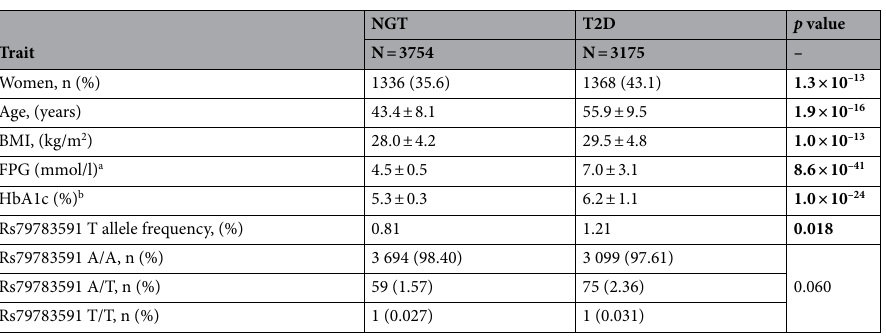
Table 1. General characteristics of Mexican adults with NGT and T2D. Data are expressed as mean ± standard deviation and N (%). NGT, normal glucose tolerance; T2D, type 2 diabetes; BMI, body mass index; FPG, fasting plasma glucose; HbA1c, hemoglobin A1c. The difference in sex ratios was analyzed using the X 2 test. Differences in means were analyzed using Student’s t-tests. Significant p values ( p < 0.05) are reported in bold. a FPG values were available in 3754 NGT and 376 T2D participants. b HbA1c values were available in 1620 NGT and 246 T2D participants.